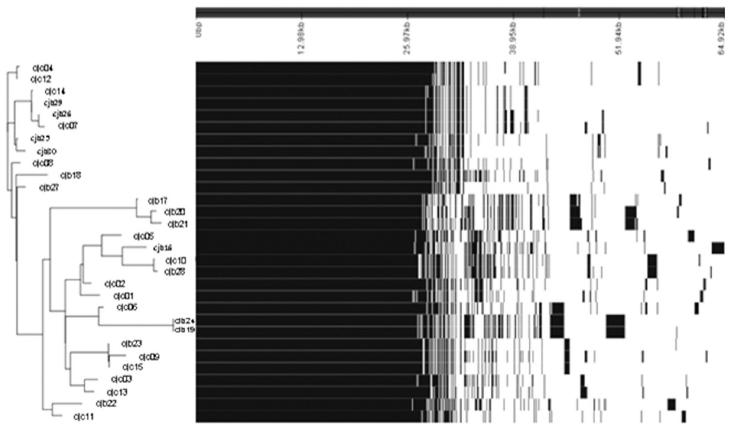
Fig 2. Visualisation of all genes that are present and absent throughout each genome.